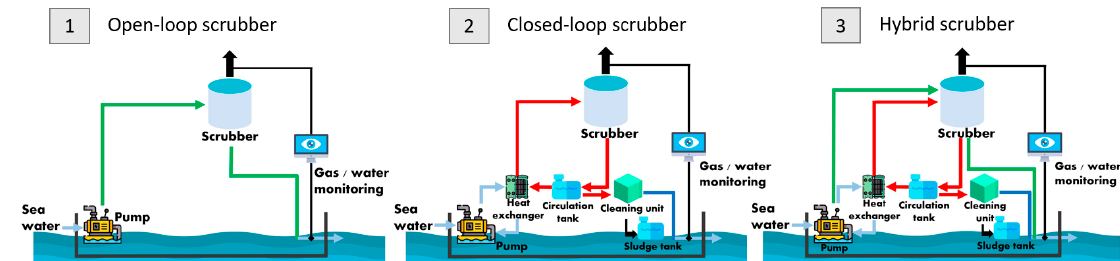
Figure 2. Outlines of scrubber